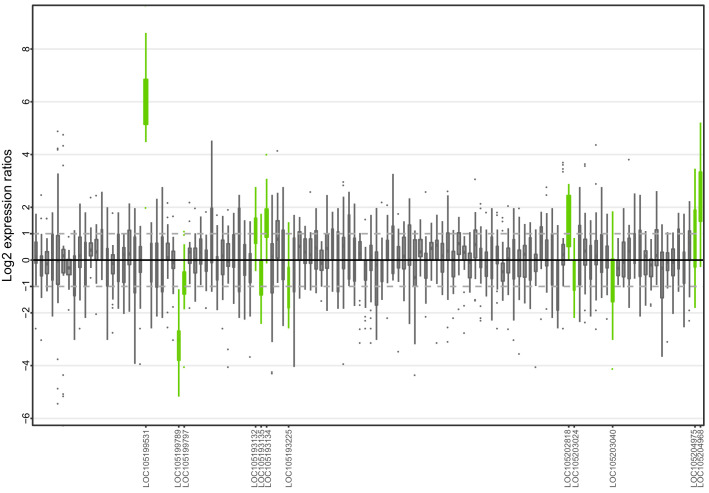
Allele-specific expression for genes in the fire ant social supergene for South American samples (information from body parts of queens and whole bodies of workers merged together).Differences in allele-specific expression between variants (y axis) for all genes in the supergene with enough expression information (x axis). Significant expression differences (BH adjusted p<0.05 from Wald test in DESeq2) are in green and the RefSeq ID of the significant gene is outlined in the x axis. Non-significant differences are marked by grey boxes. Within each plot, each box shows the distribution of log2 expression ratios between SB and Sb. Positive values indicate higher expression in SB; negative values indicate higher expression in Sb. The dashed line shows log2 expression ratios = 1, that is a two-fold gene expression difference in either direction. Genes are in chromosomal order, showing that genes with allelic biases in either direction are distributed throughout the supergene, rather than localized in a manner that would be expected by strata of differentiation. Thicker boxes have higher median read counts than thinner boxes.Figure 1—figure supplement 2—source data 1.Allele-specific expression for genes in the fire ant social supergene for South American samples.The columns in the dataset stand for: refseq_id, gene ID in the RefSeq database; body_part, body part from which the RNA was extracted; median_expression, median DESeq2 normalized expression per gene across all samples per body part; mean_lfc, mean log2 fold changes between Sb and SB allelic expression per body part; sd_lfc, standard deviation of the log2 fold changes between Sb and SB allelic expression per body part; littleb_expression, DESeq2 normalised read counts for the Sb allele, bigB_expression, DESeq2 normalised read counts for the SB allele; sample_id, ID for the replicate; population, population of origin of the replicate, total_expression, combined SB Sb expression per gene per replicate; lfc_SB-Sb, log2 fold changes between SB and Sb DESeq2 normalized read counts; normalized_lfc, Z scores centered log2 fold changes between SB and Sb, the mean log2 fold change per body part is substracted from the log2 fold change per gene per replicate and divided by the standard deviation per body part; significant, whether a gene show significant differences in expression levels between Sb and SB according to either our linear mixed effects model or DESeq2's Wald test.